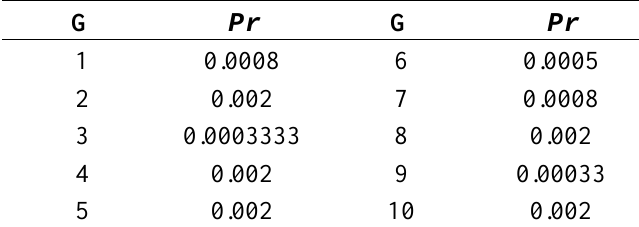
Table 1. Probability of conventional generator trip.